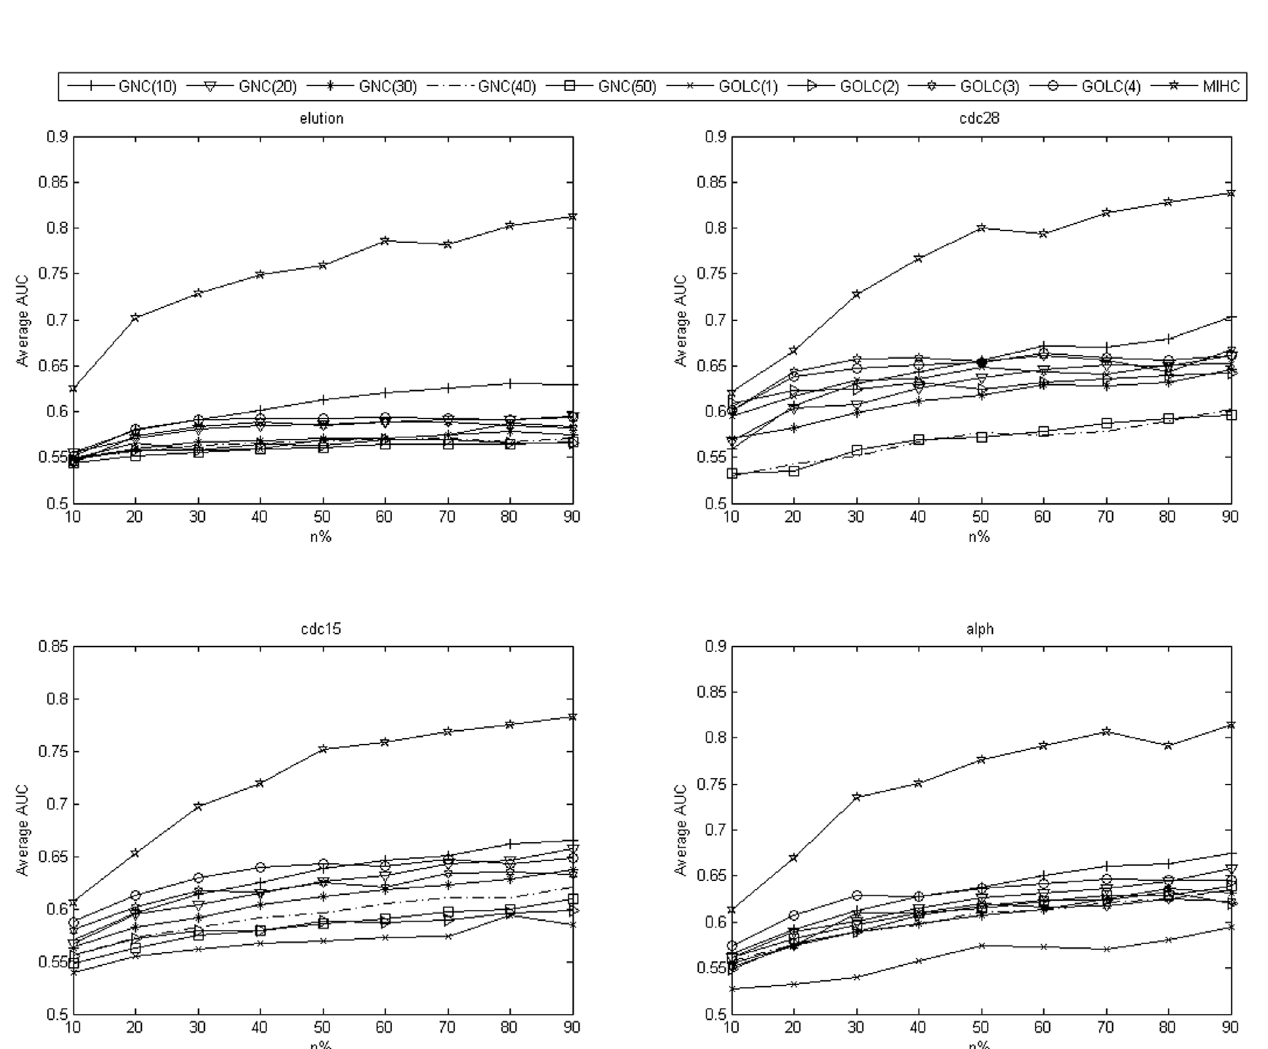
Figure 4. Average AUC obtained from each learning system by MLSVM in all datasets. doi:10.1371/journal.pone.0090962.g004 PLOS ONE |